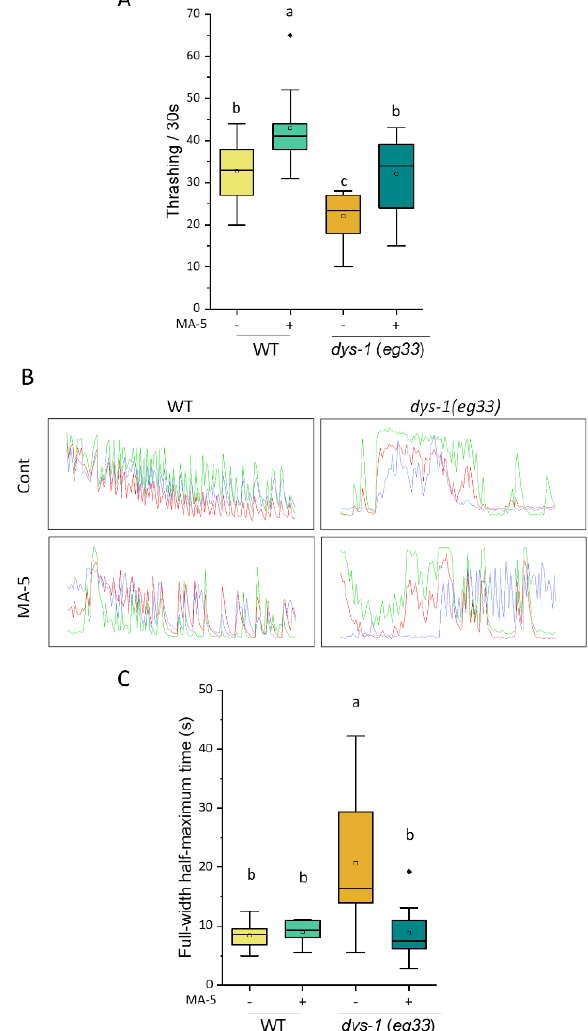
Figure 2. MA-5 suppressed DMD disease model symptoms on motor activity reduction and exten- sion of cytoplasmic Ca 2+ oscillations with muscle contraction. ( A ) Movement capacity of ATU3305 worms in liquid media. Locomotory performances were determined in 1ml M9 for each 30 s ( n = 10 worms/treatment). Different letters indicate significant differences ( p ≤ 0.05) by one-way ANOVA and Tukey’s HSD test with all data points including outliers. Transgenic C. elegans dys-1 null mutation ATU3305 ( dys-1(eg33) ccIs4251 [ Pmyo3::nucGFP-LacZ + Pmyo-3::mitochondrial GFP ] aceIs1 [ Pmyo-3::mitochondrial LAR-GECO+ Pmyo2::RFP ]) and wild-type ATU3301 ( ccIs4251 [ (pSAK2) myo-3p::GFP::LacZ::NLS+(pSAK4)myo-3p::mitochondrialGFP + dpy-20(+) ] I, acels1 II) were monitored on day 2 of adulthood. ( B ) Cytoplasmic Ca 2+ oscillations with muscle contraction in different three muscle cells (indicated as green, red and blue) with wild-type (ATU2301) and dys-1 null mutant (ATU2305) in the presence or absence of MA-5 treatment for 300 s. Transgenic C. elegans dys-1 null mutation ATU2305 ( goeIs3 V, aceIs1 II, dys-1 ( eg33 ) I) and wild-type ATU2301 ( goeIs3; aceIs1 ) were monitored on day 2 of adulthood. ( C ) Peak width measured as the full width at half maximum (FWHM) of cytoplasmic Ca 2+ was analyzed ( n = 12–25/treatment). Different letters indicate signifi- cant differences ( p ≤ 0.05) by Dunn’s test with all data points including outliers. Data are shown as box plots to indicate median (central line) and mean (square mark). Cont: control treated with 0.1% DMSO; MA-5: 10 µ M; WT: wild type (strain ATU3301); Diamond mark: outlier